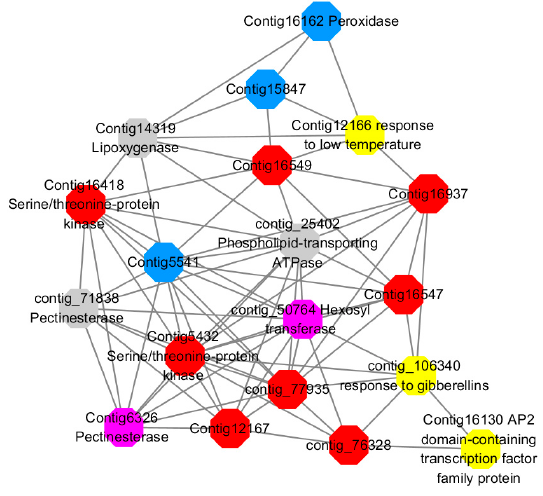
Figure 27. Interaction between genes in Module 5.